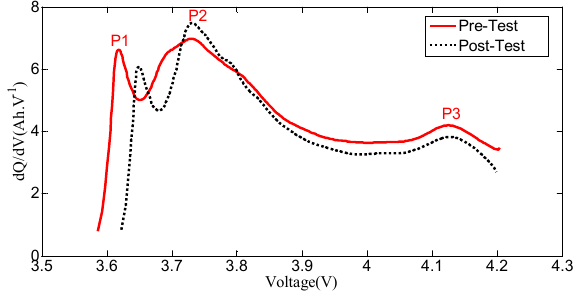
Figure 11. Incremental capacity (IC) curves before and after vibration.